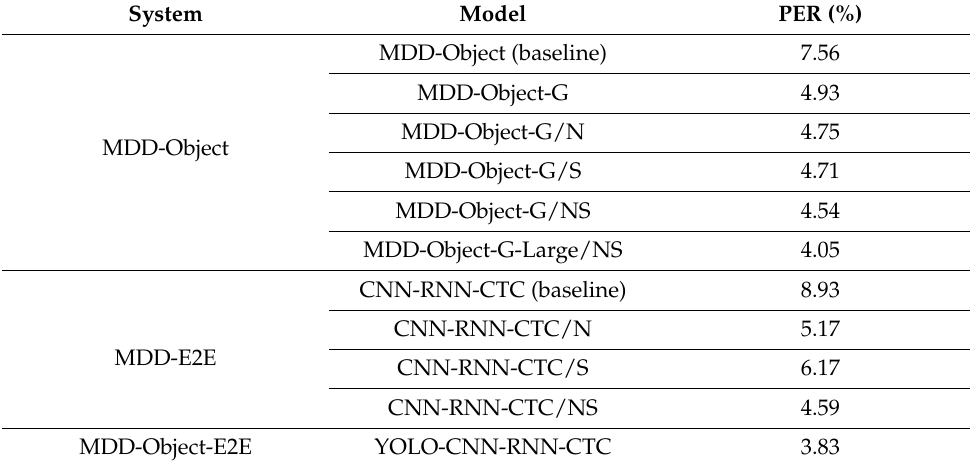
Table 10. PER of the proposed MDD-object models MDD-E2E models and the fusion model.